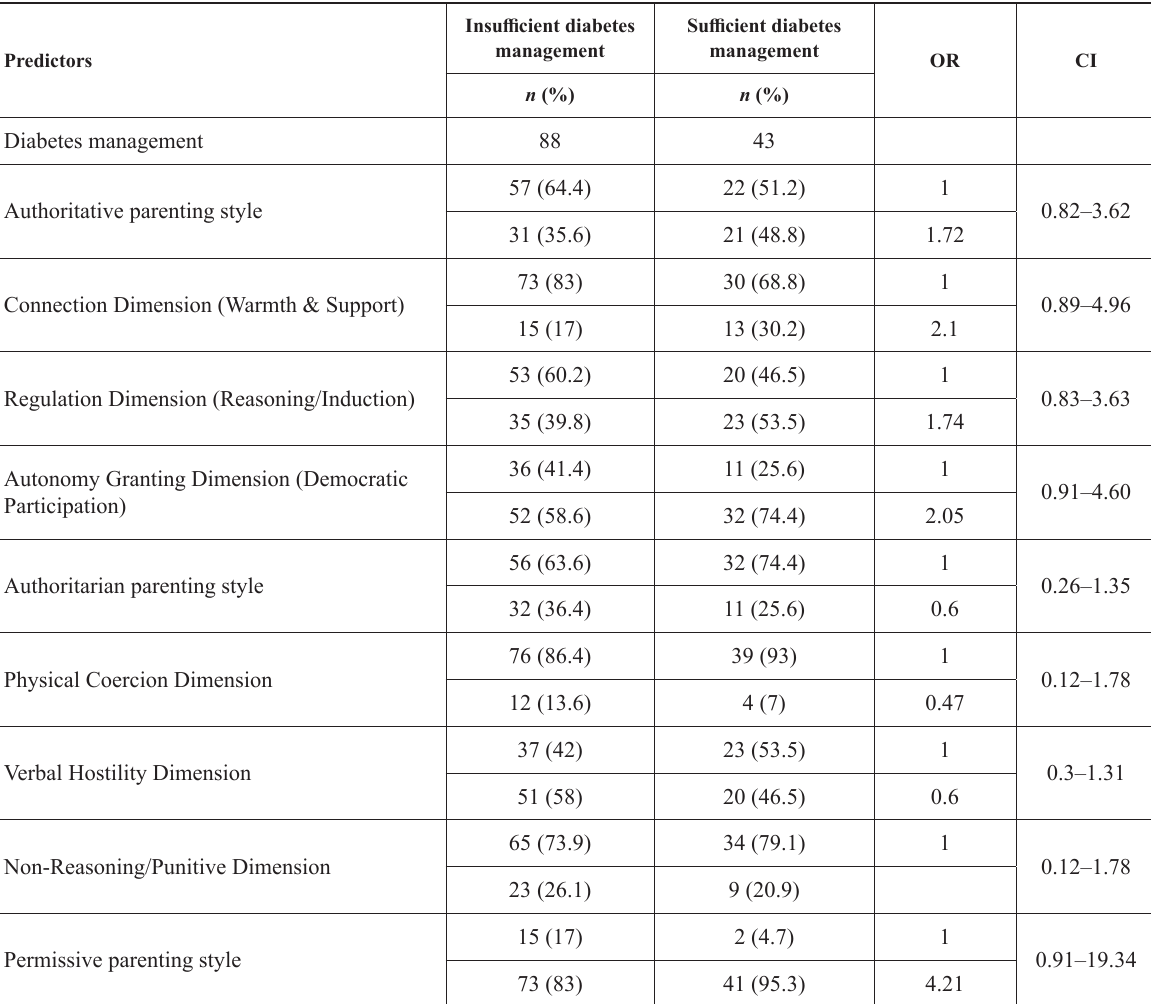
Table 6. Children’s T1DM management and mothers’ PS scales and subscales (total sample, N = 131): results of univariate and multivariate logistic regression